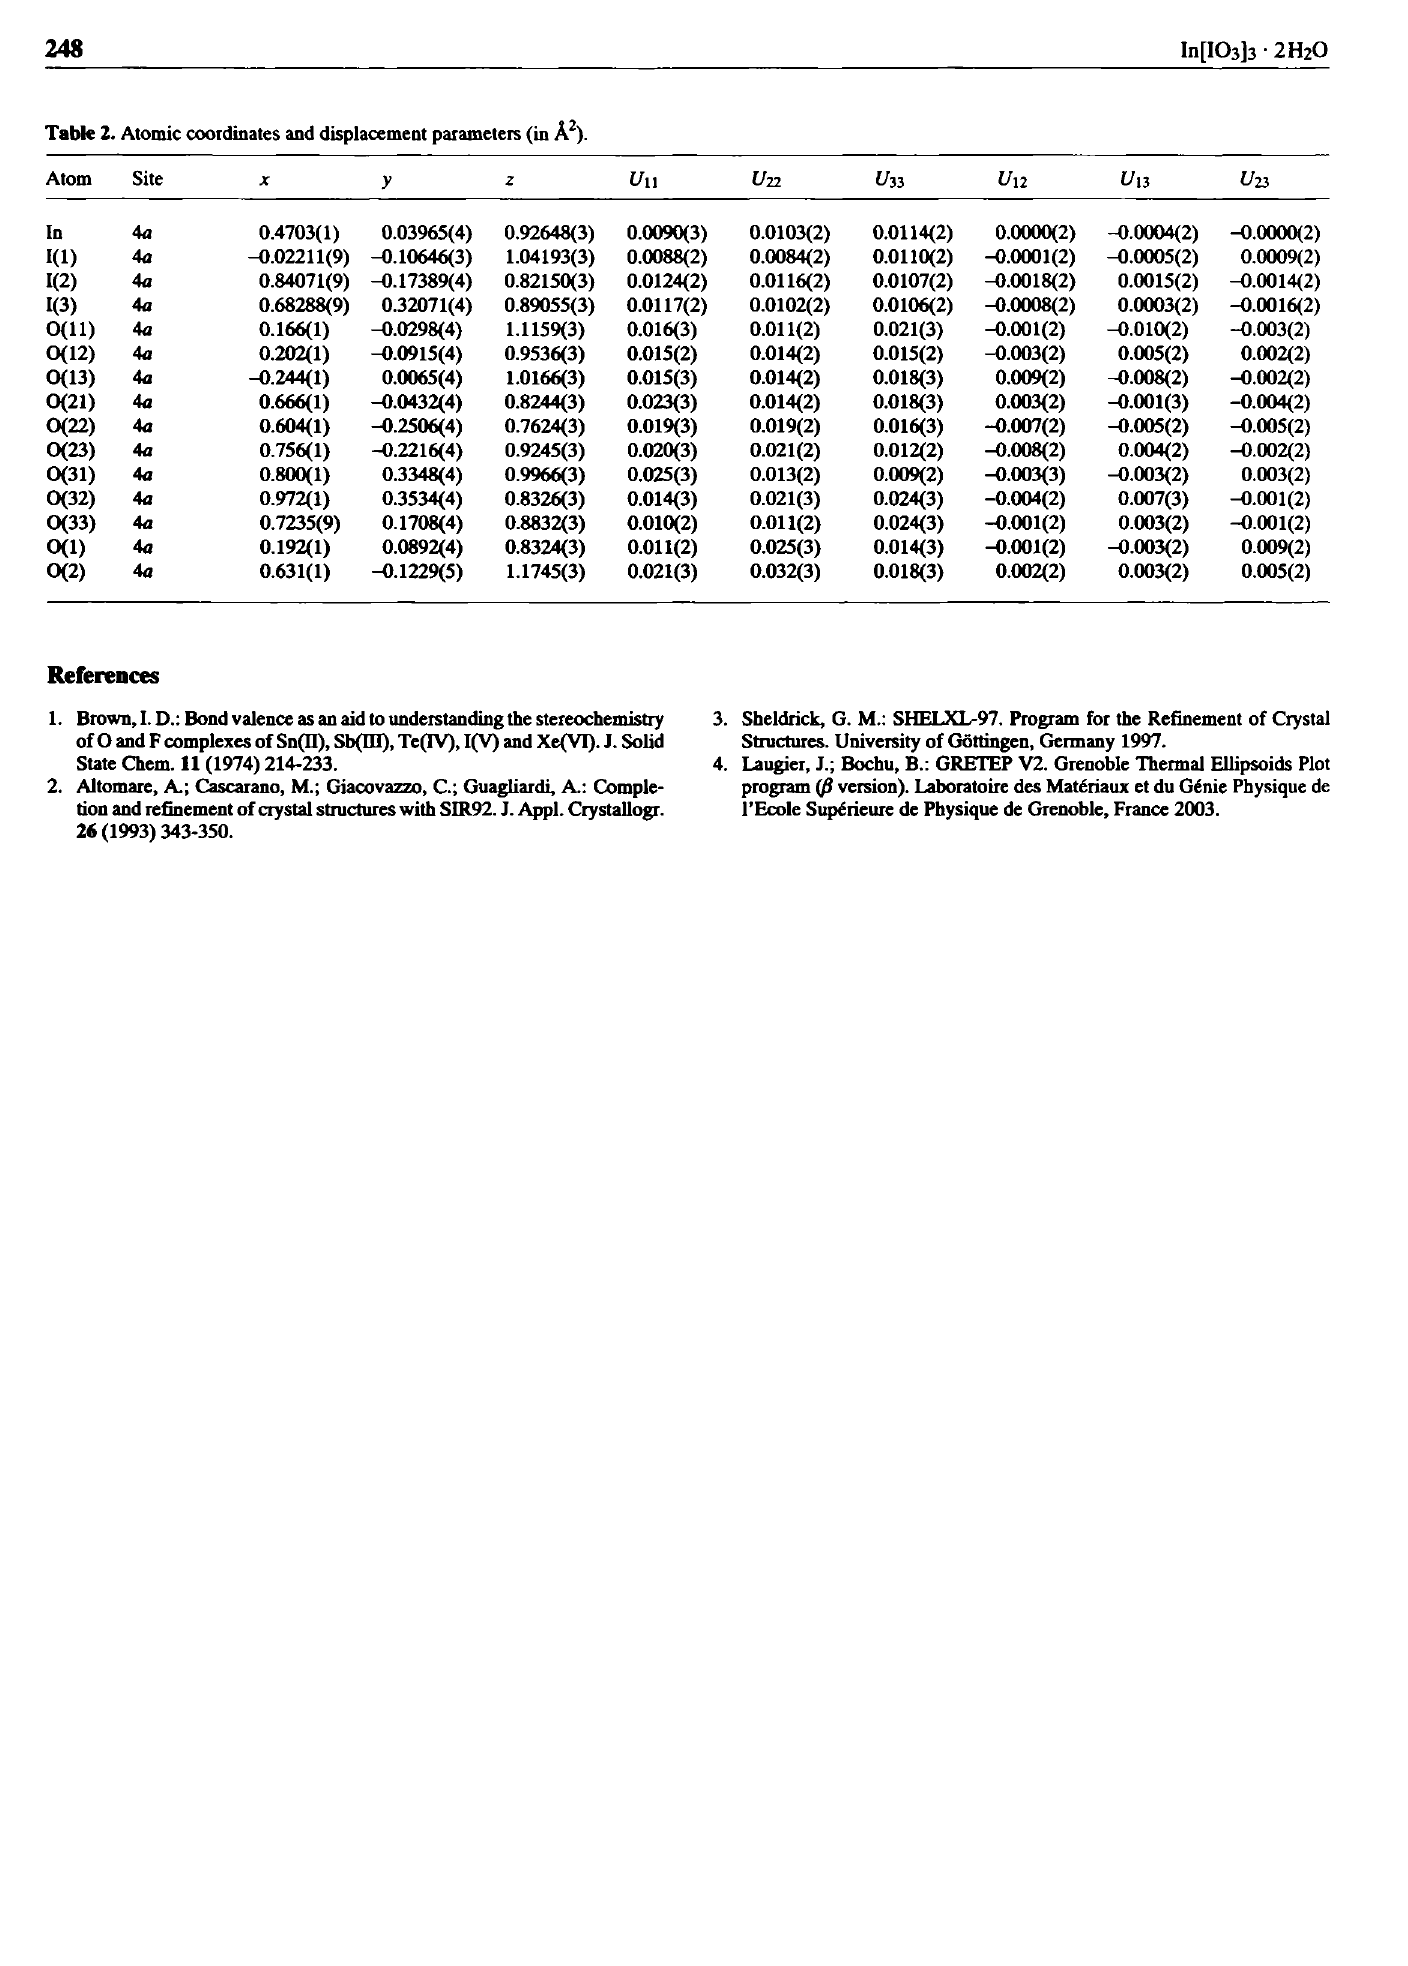
Table 2. Atomic coordinates and displacement parameters (in Ä 2